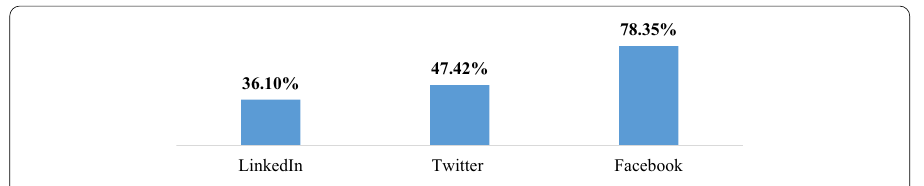
Fig. 5 Distributions of the use of social media